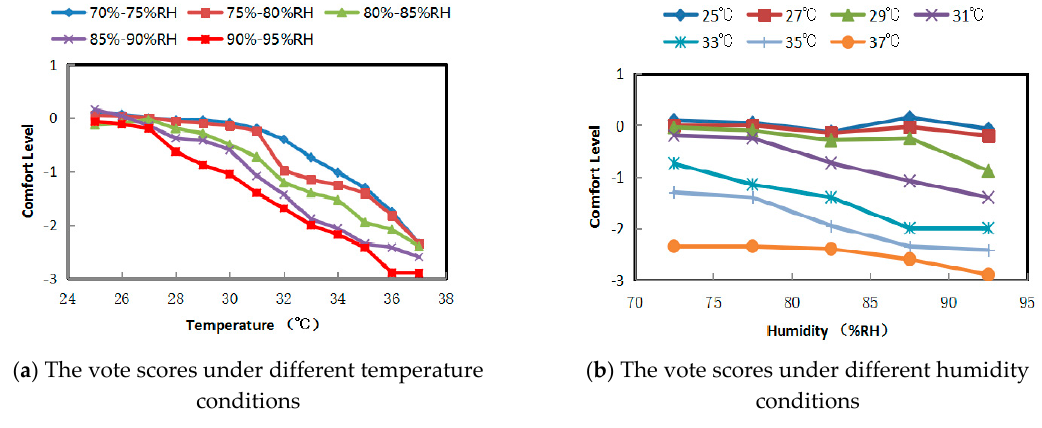
Figure 5. Relationship between comfort level and temperature/humidity.